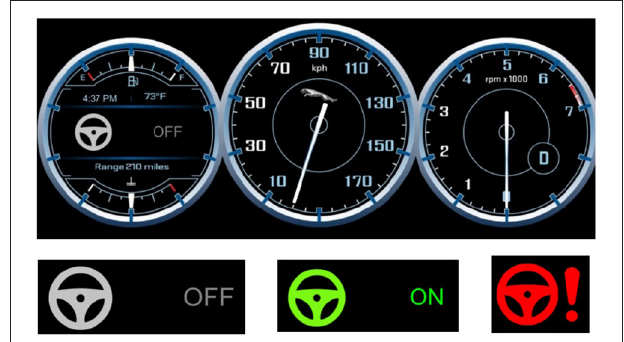
FIGURE 3 | Upper part: The dashboard displaying the icon indicating the autopilot mode, the speed of the car and the number of engine’s revolutions per minute. Bottom-left: gray icon—Autopilot OFF, Bottom-middle: green icon—Autopilot ON, Bottom-right: Red icon—Takeover Request (TOR).